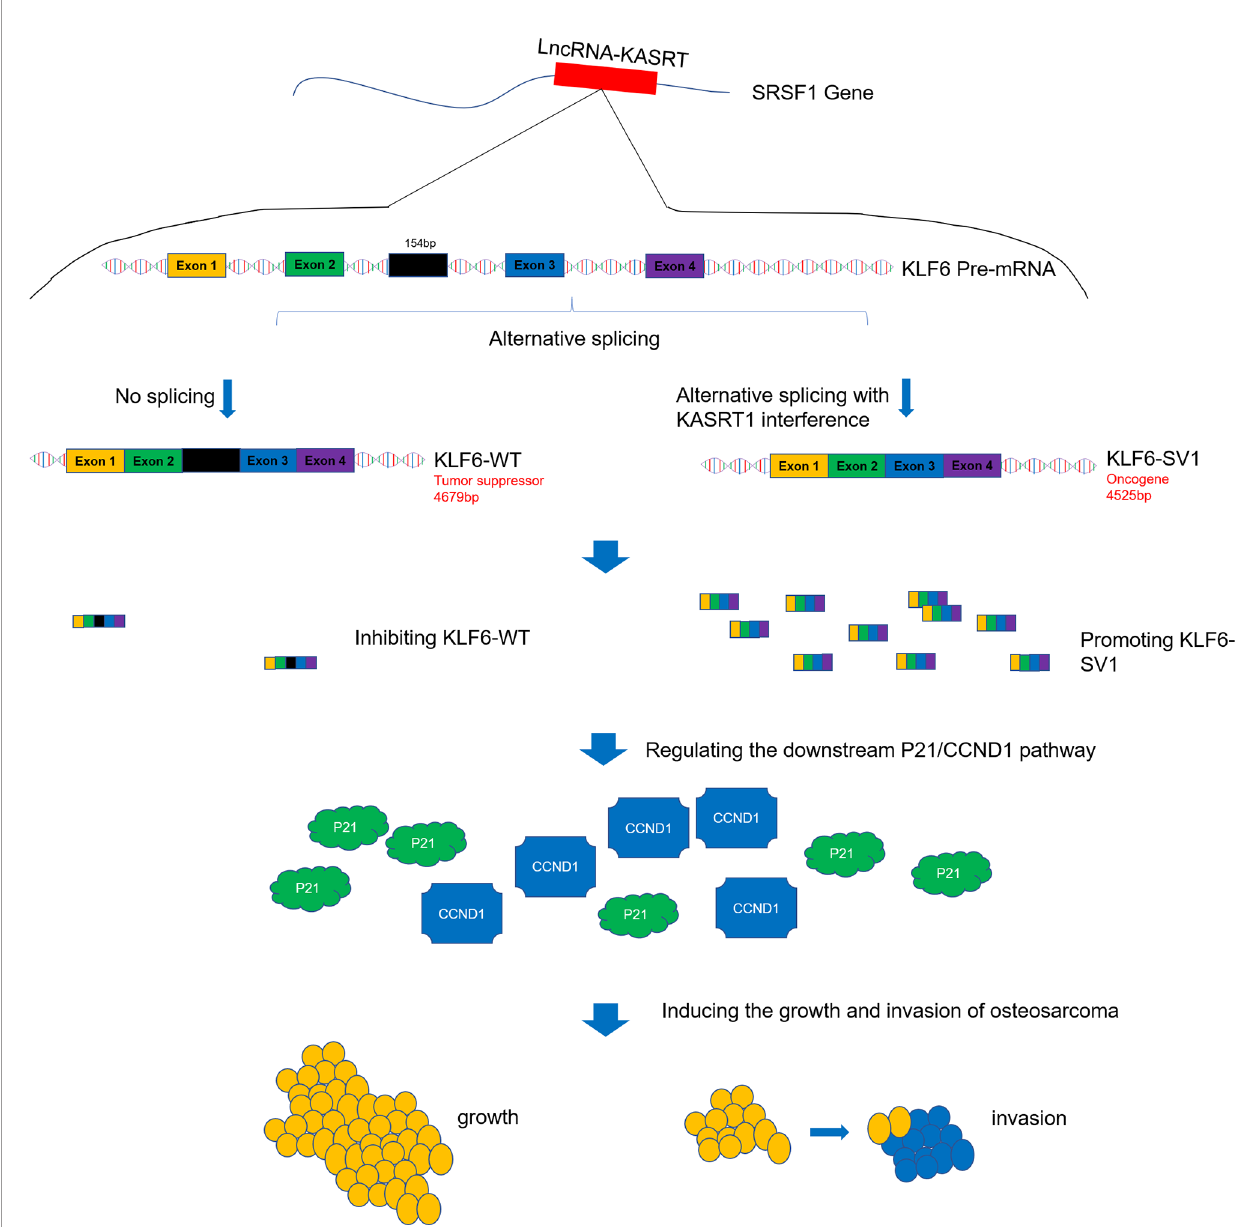
FIGURE 11 | Visual summary of the main fi ndings. Lnc-KASRT is located on SRSF1, interacts with SRSF1, and then regulates alternative splicing of KLF6 to promote KLF6-SV1 coding while inhibiting KLF6-WT coding, subsequently modifying the P21/CCND1 pathway, fi nally leading to increased growth and invasion of